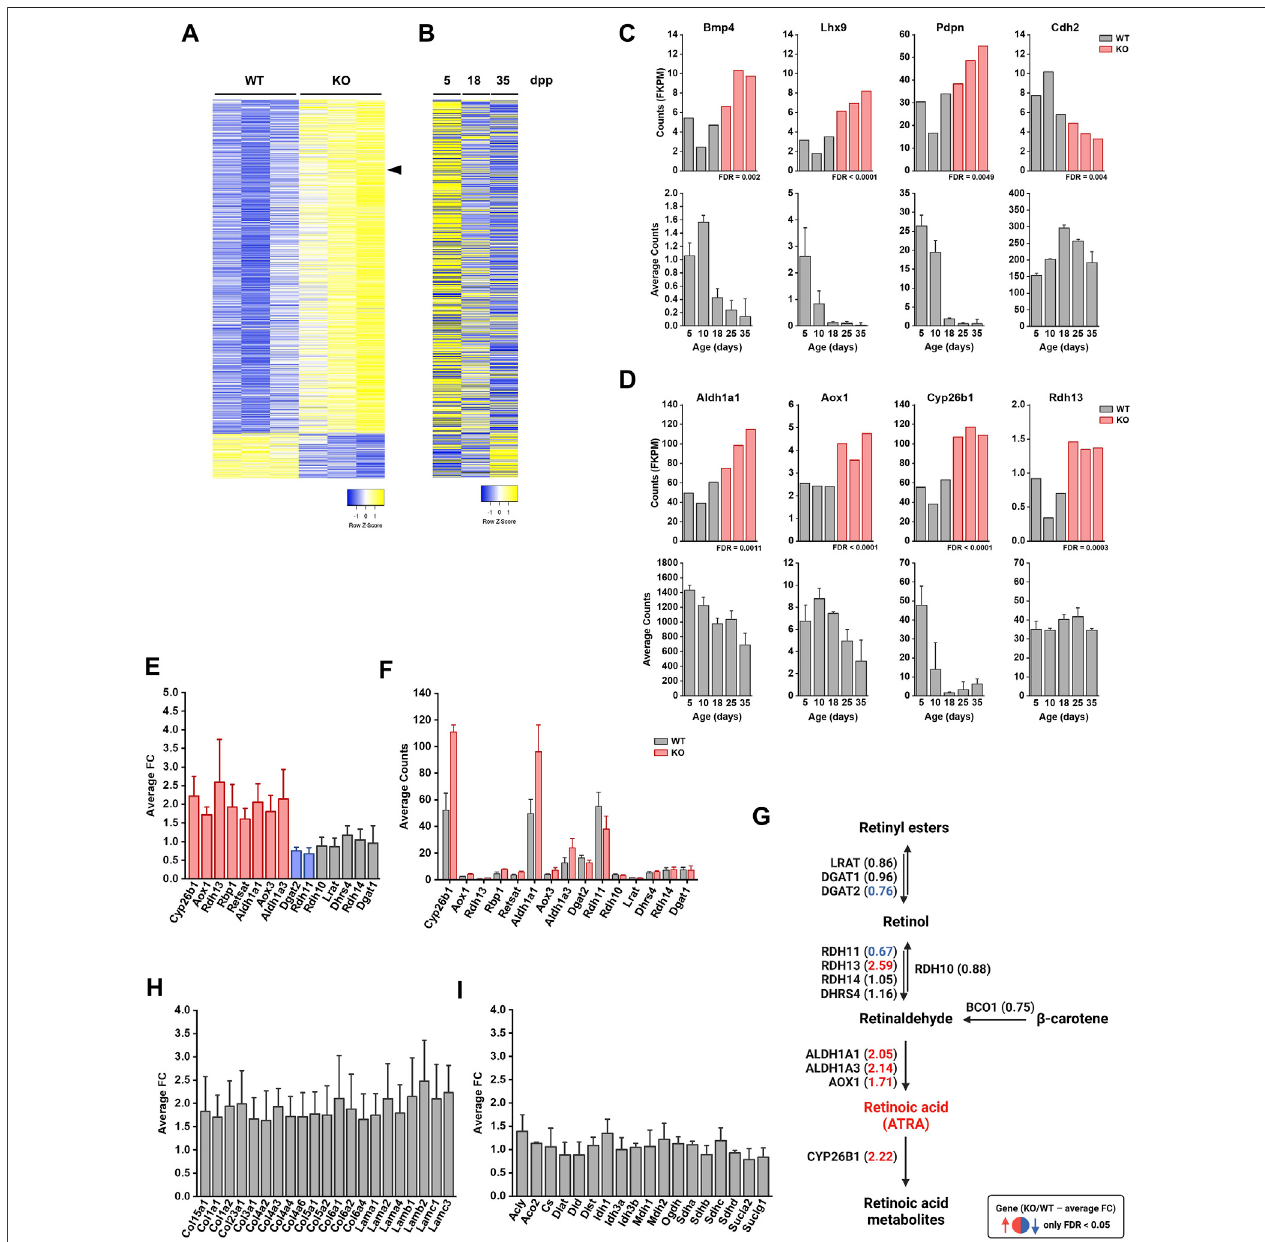
FIGURE 5 | FBXO38-de fi cient Sertoli cells exhibit a maturation defect. (A) Normalized counts (fragments per kilobase million, FKPM) from RNA-seq analysis of Fbxo38 wild-type (WT) and knockout (KO) young adult (8 weeks old) Sertoli cells were visualized as a heat map showing gene expression normalized to the highest and lowest obtained count. Only 1,170 signi fi cantly regulated genes (FDR < 0.05) are shown. The arrowhead points to Cyp26b1 gene. (B) Publicly available data of gene expressions in Sertoli cells from a different age of juvenile mouse males. The same set of genes as in (A) was visualized as a heat map showing gene expression normalized to the highest and lowest obtained count. Each time point represents the mean value of three different Sertoli cells isolations (GEO accession number GSE59698) (Zimmermann et al., 2015). Publicly available data were normalized using a GREIN application (http://www.ilincs.org/apps/grein/) (Mahi et al., 2019); dpp, days postpartum. (C) Upperpanel: Expression(FKPM) offour markersofSertolicellmaturation(Bmp4,Lhx9,Pdpn,and Cdh2)in Fbxo38 WT(grey)and KO(red)Sertoli cells (dataset as in A). Lower panel: Timecourse of publicly available gene expression of the same set of genes during Sertoli cell maturation. Each time point